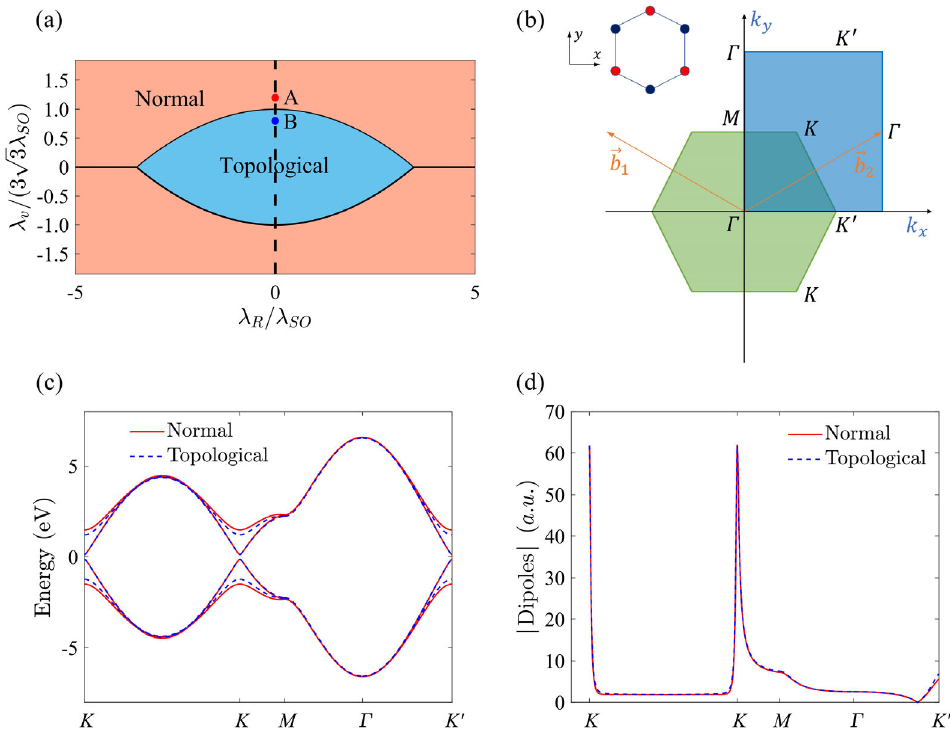
¼ 0 . 06 t , and lattice constant ffiffiffi p ffiffiffi p SO 3 λ Þ ¼ 1 . 2 ] is in the normal phase and the B point [blue, λ ð 3 3 λ Þ ¼ 0 . 8 ] is in the ν = SO SO ¼ 0 . (b) Brillouin zone, where the orange arrows denote reciprocal R